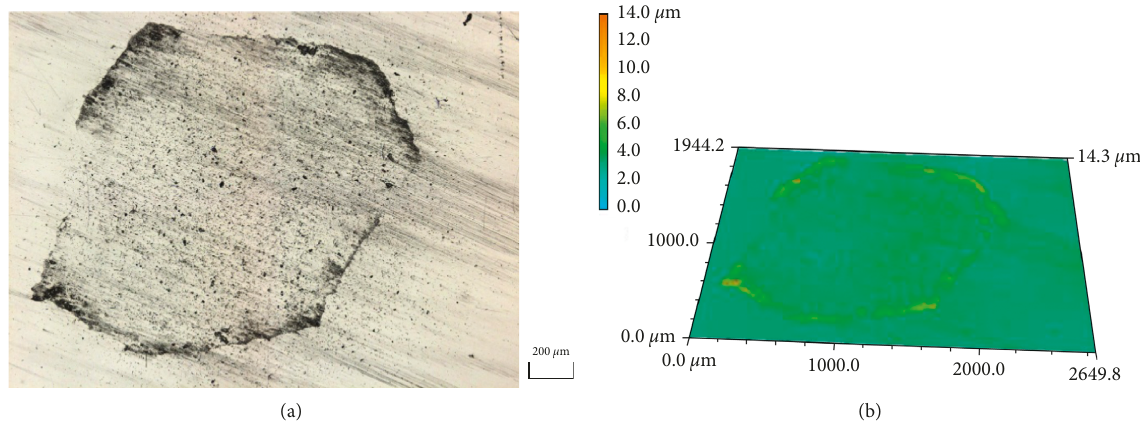
s (cid:31) 25MPa, a (cid:31) 22 μ m, and B (cid:31) 3mm). (a)